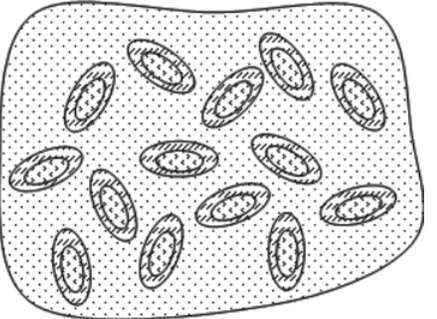
Figure 4: Scheme of a bilayer ellipsoid (A) and its effective ellipsoid